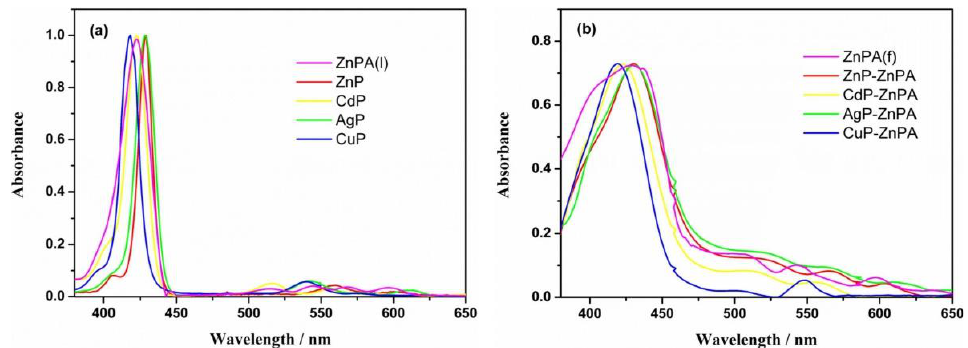
Figure 9. UV – visible absorption spectra of different metalloporphyrins ( a ) in CH 2 Cl 2 solution and ( b ) on TiO 2 thin films. Reproduced from reference [58] with permission from Elsevier, copyright 2022.